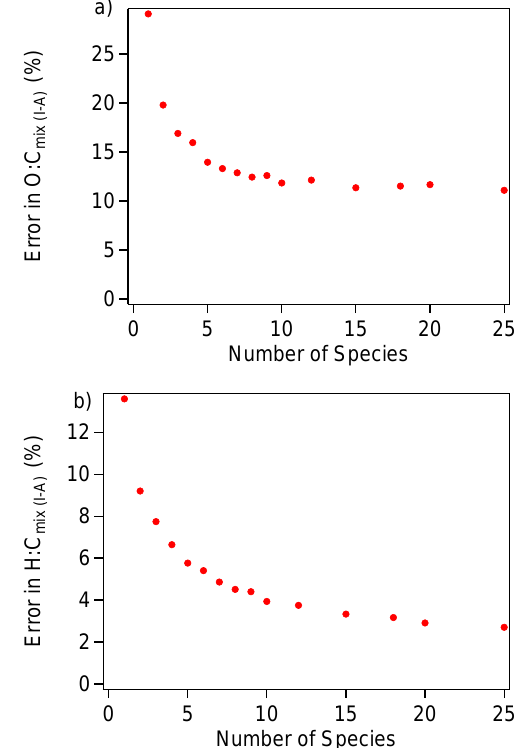
Figure 6. (a) Errors in Improved-Ambient O:C ratio of organic standard molecule mixtures as a function of number of species in the mixture. (b) Errors in Improved-Ambient H:C ratio of the organic standard molecule mixtures as a function of number of species in the